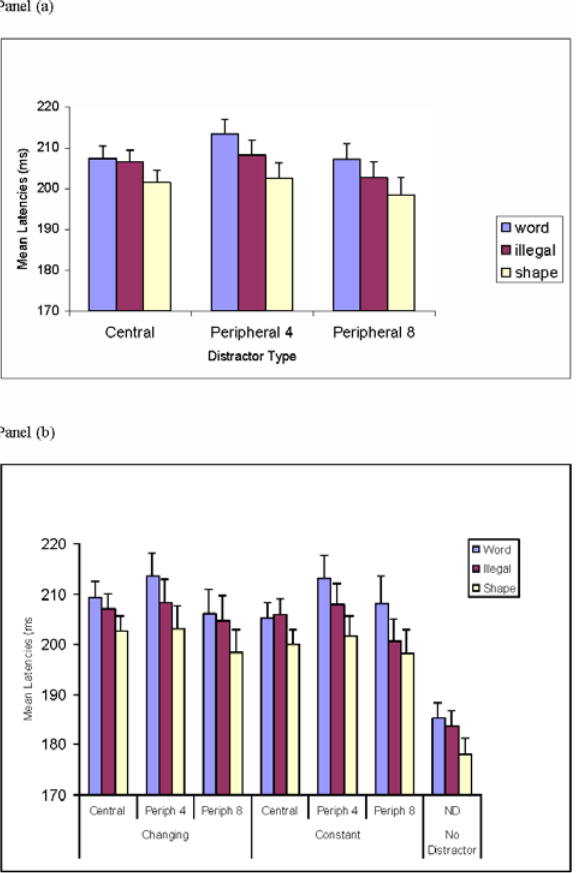
Figure 3: Panel (a) . The mean saccade latencies for each of the three Distractor Types at each of the three Eccentricities in Experiment 3 . Panel (b ). The mean saccade latencies for each of the three Distractor Types, at each of the three Eccentricities, for both Changing and Repeated distractors. Error bars denote one standard error from the